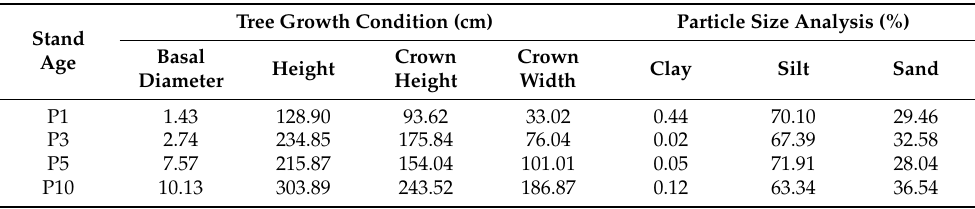
Table 1. Tree growth condition and particle size analysis in pomegranate plantations with an age sequence of pomegranate